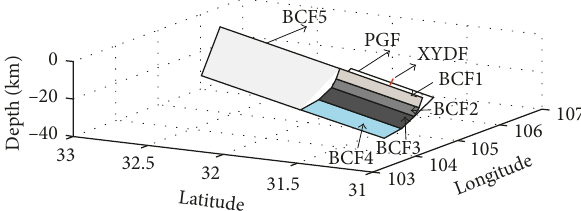
Figure 2: 3-D model of the Wenchuan